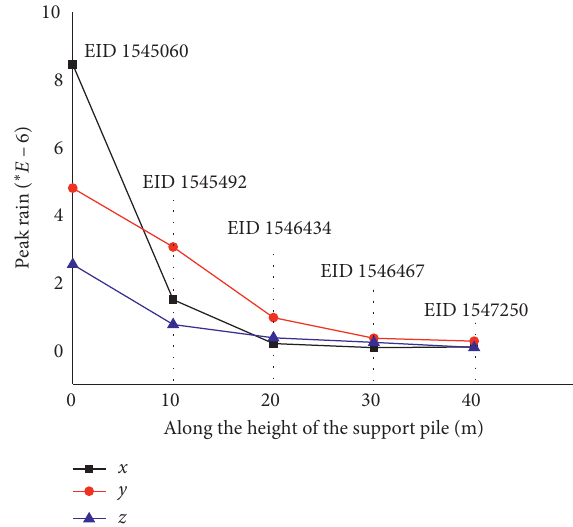
Figure 13: The response trend of the peak stress with the increase in the supporting pile height.